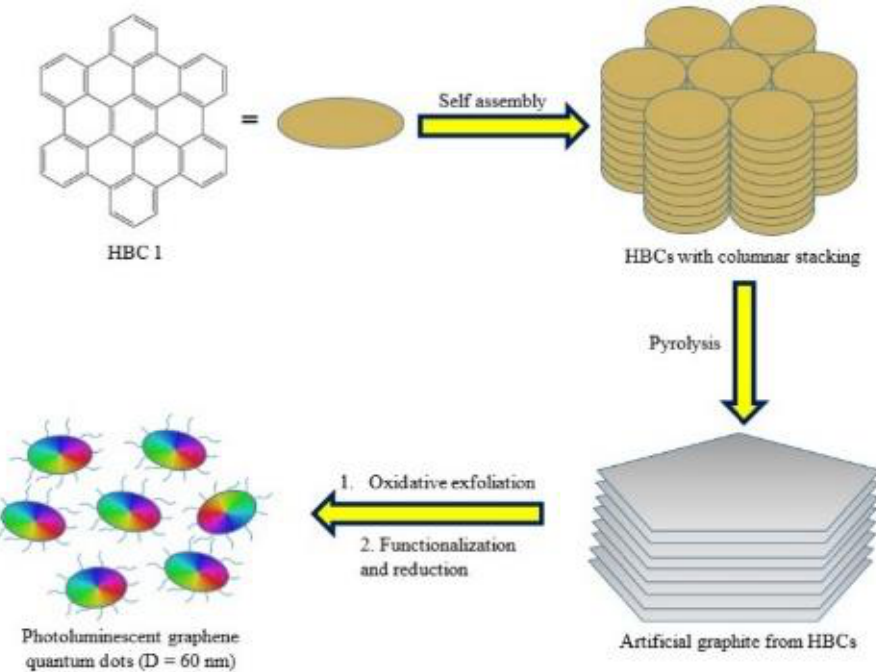
Figure 14. Synthesis of GQDs from HBC via soft-template route. Adapted with permission from Ref. [173], Copyright (2011), American Chemical Society.